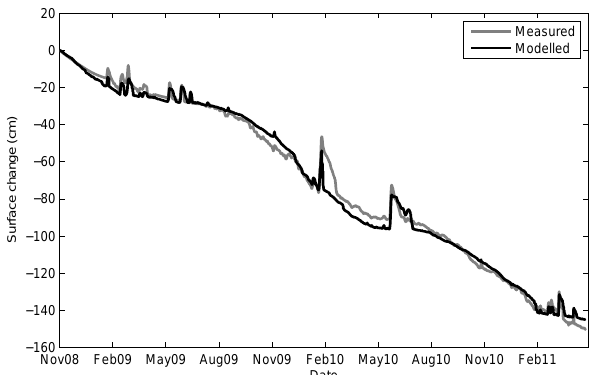
Fig. 3. Comparison of measured and modelled surface height change between 1 November 2008 and 30 April 2011. The mass balance at G-AWS was negative over the period, and the measured surface change was − 1.5m. The root mean square error (RMSE) of the model is 4.1cm (which corresponds to a normalized RMSE of 3%), and a Nash–Sutcliffe statistic of 0.99.